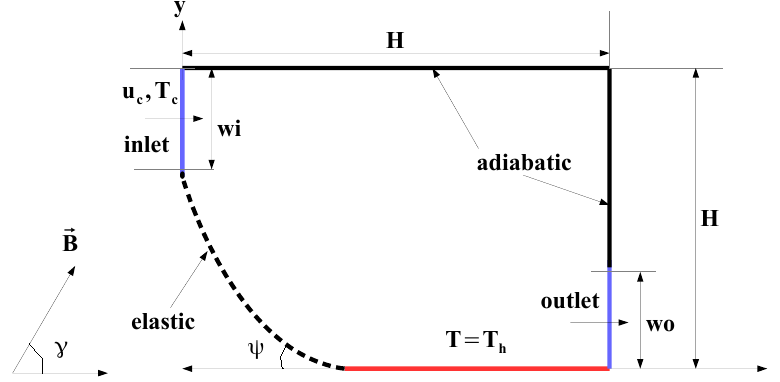
Figure 1. Schematic view of VC system with inclined elastic wall under